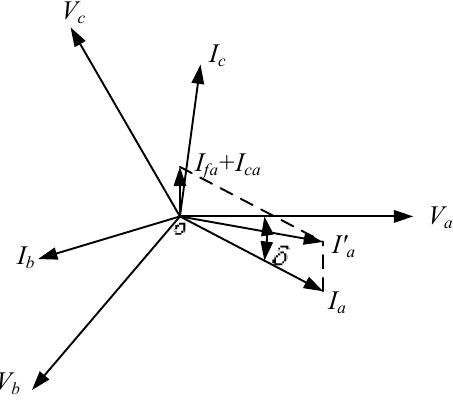
Figure 9. Phasor diagram of the voltage and current of the load winding.